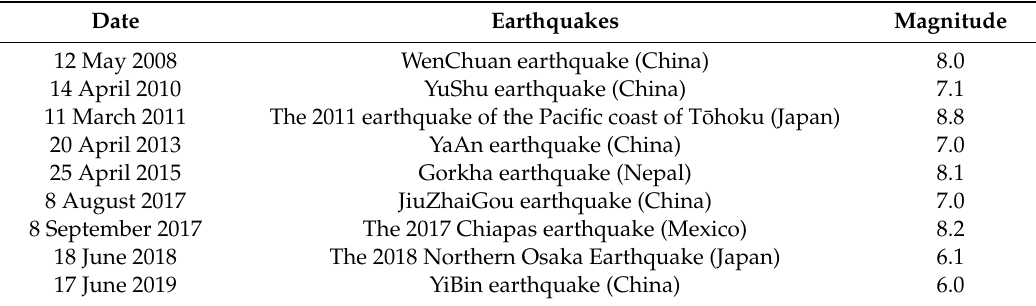
Table 1. Major earthquakes in the last